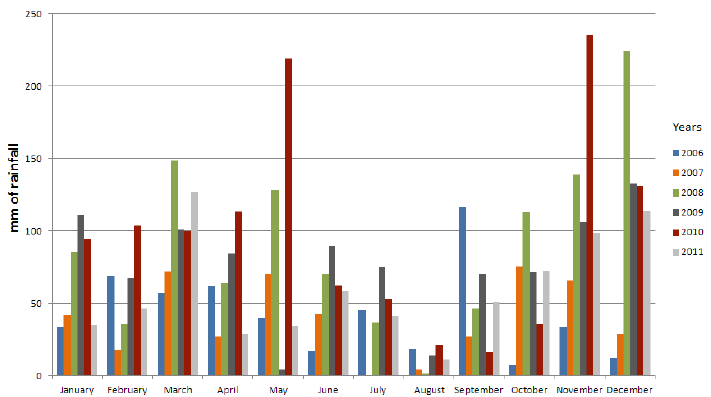
Figure 1. Monthly rainfall data of the experimental site during the tests (2010–2011). Data since 2006 indicate the climatic average.